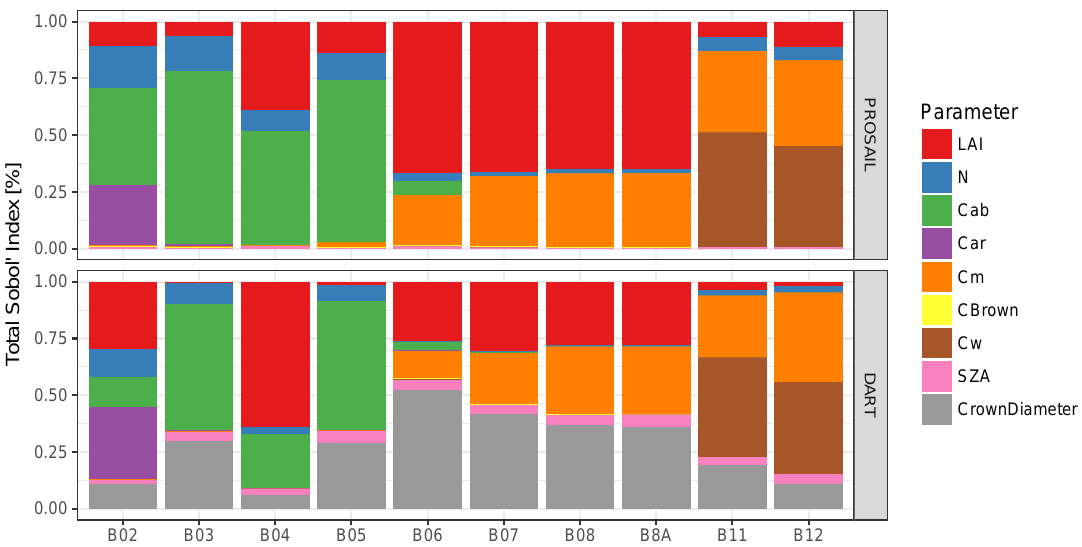
Figure 8. Global sensitivity of S2A MSI spectral bands to PROSAIL and DART input parameters according to Sobol’ Indices. Total Sobol’ Indices were normalised per band to sum up to 1. For band specifications, see Table 1 and for parameters see Table